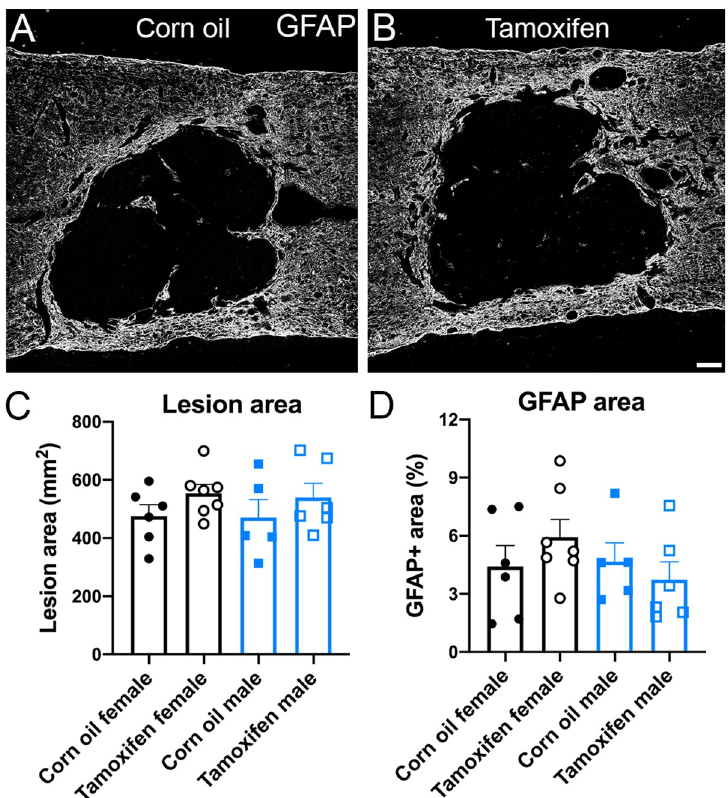
Fig 6. Astrocyte reactivity and lesion size are not altered by delayed short-term tamoxifen gavage after SCI. (A-B) Tiled confocal z-stacks of GFAP immunoreactivity in (A) control and (B) tamoxifen mice. Scale bar = 100 μ m. Quantification of (C) lesion area and (D) GFAP proportional area revealed no significant differences between groups. Data presented as mean + SEM. One-way ANOVA with Tukey post hoc test; corn oil female n = 6; tamoxifen female n = 7; corn oil male n = 5; tamoxifen male n =